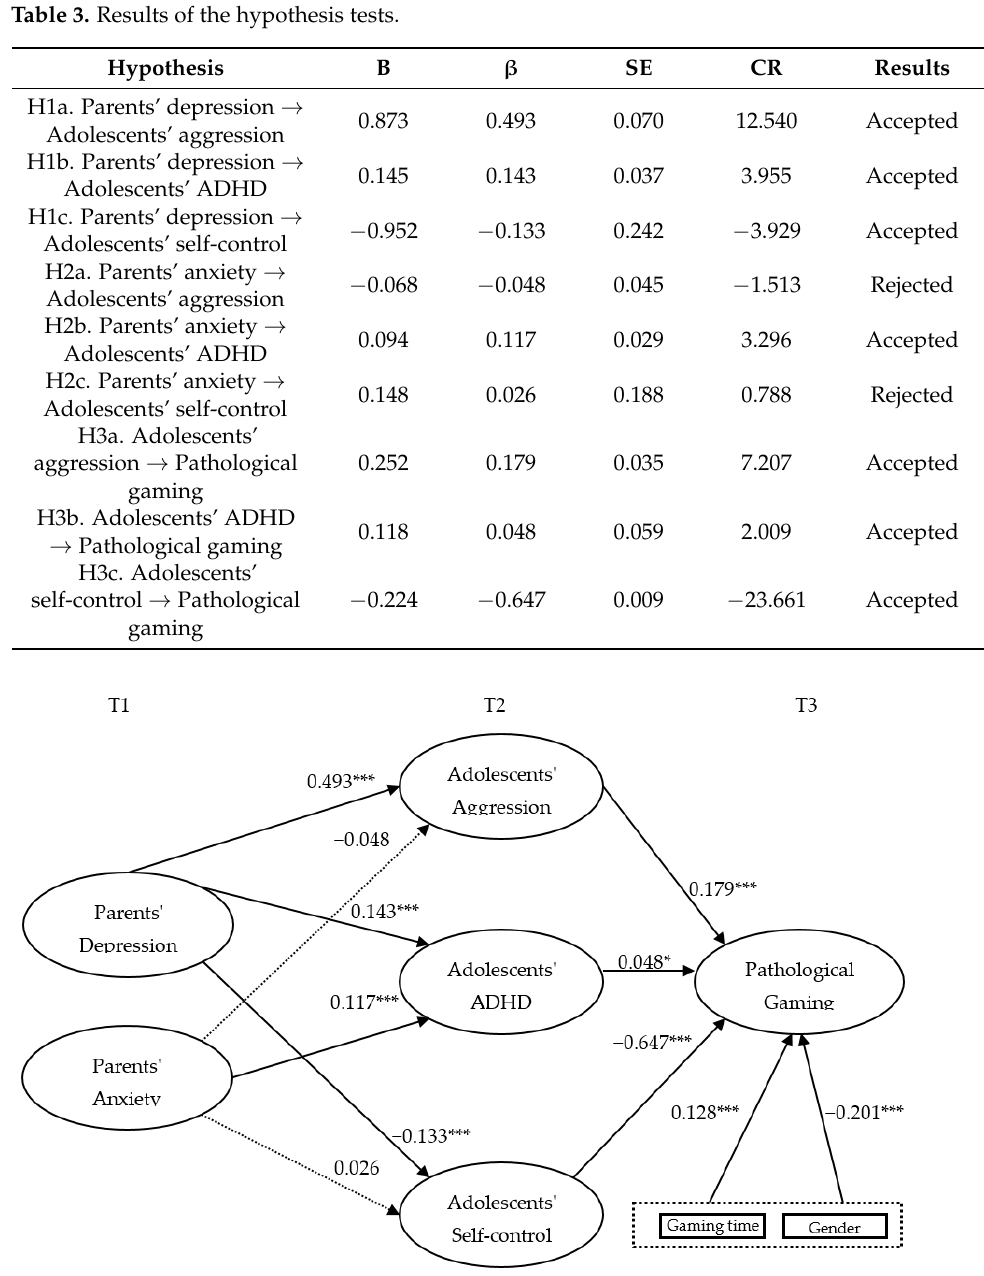
Figure 2. Research model and hypothesis. *p < 0.01, **p < 0.001 , ***p <